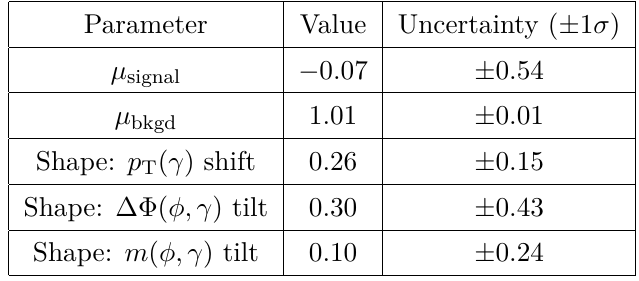
Table 3 . Post-fit parameter values and their associated